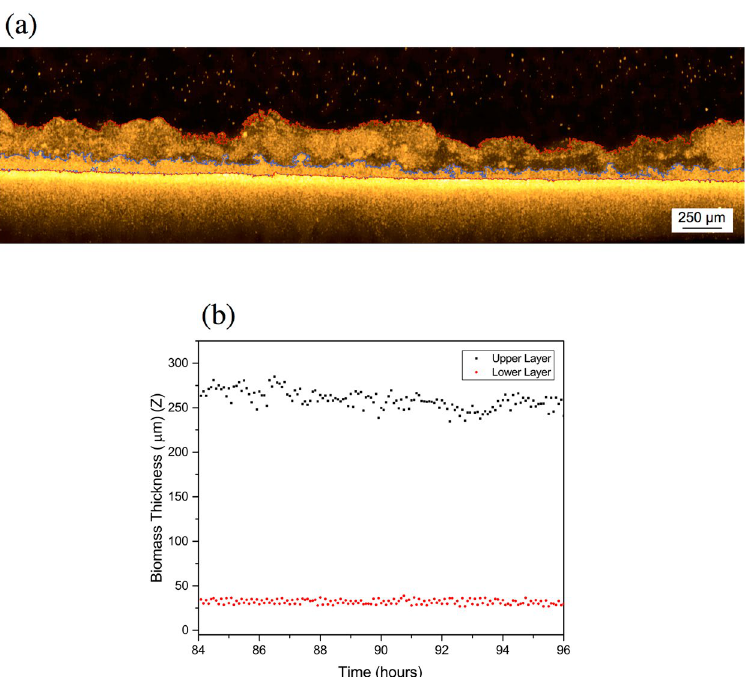
Figure 6. ( a ) Morphology observed after 84 h non-destructively and directly in the filtration tank with OCT. The biofouling presents a double-layered structure. The lines in red and in blue delimit the upper and lower layer, respectively. ( b ) Average thickness of the double layers over the time. The structure was monitored for a period of 12 h (OCT scans acquired every 5 min) after 84 h from the beginning of the